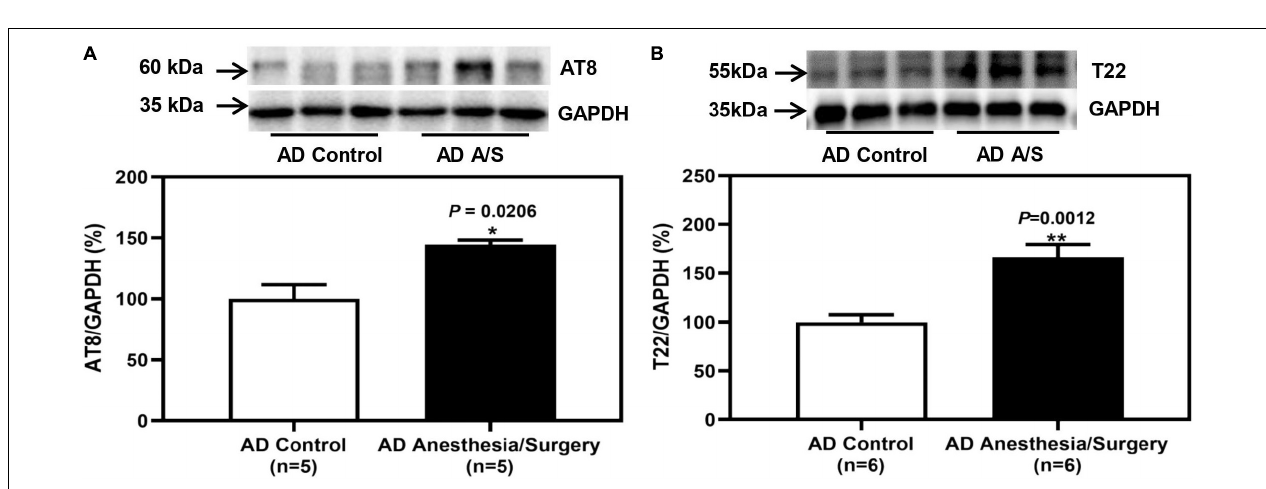
FIGURE 4 | The effect of anesthesia and surgery on the levels of p-tau and tau oligomers in the hippocampus of 5XFAD Tg mice. (A,B) The difference in brain amounts of phosphorylated tau at Ser202 and Thr205 sites (AT8) and tau oligomers (T22) in the hippocampus of postoperative 24 h of 5XFAD Tg mice in control and anesthesia/surgery group. In 5XFAD Tg mice, the levels of AT8 and T22 in the hippocampus were significantly increased at postoperative 24 h. Results are expressed as mean ± SEM. Student t -test. ** P < 0.005 vs. untreated controls. * P < 0.05 vs. untreated